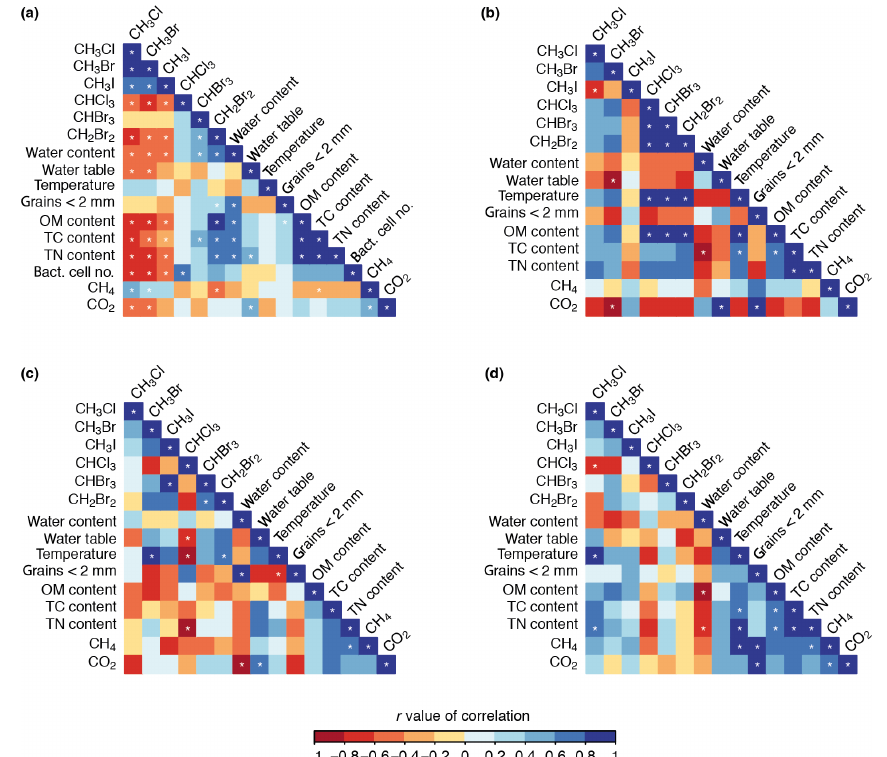
Figure 6. Correlations between halocarbon fluxes and the chemical, physical, and biological variables across all sites (a) , the disturbed mat site (b) , the established mat site (c) , and the tundra site (d) . White stars indicate correlations with 95% confidence ( p < 0 .